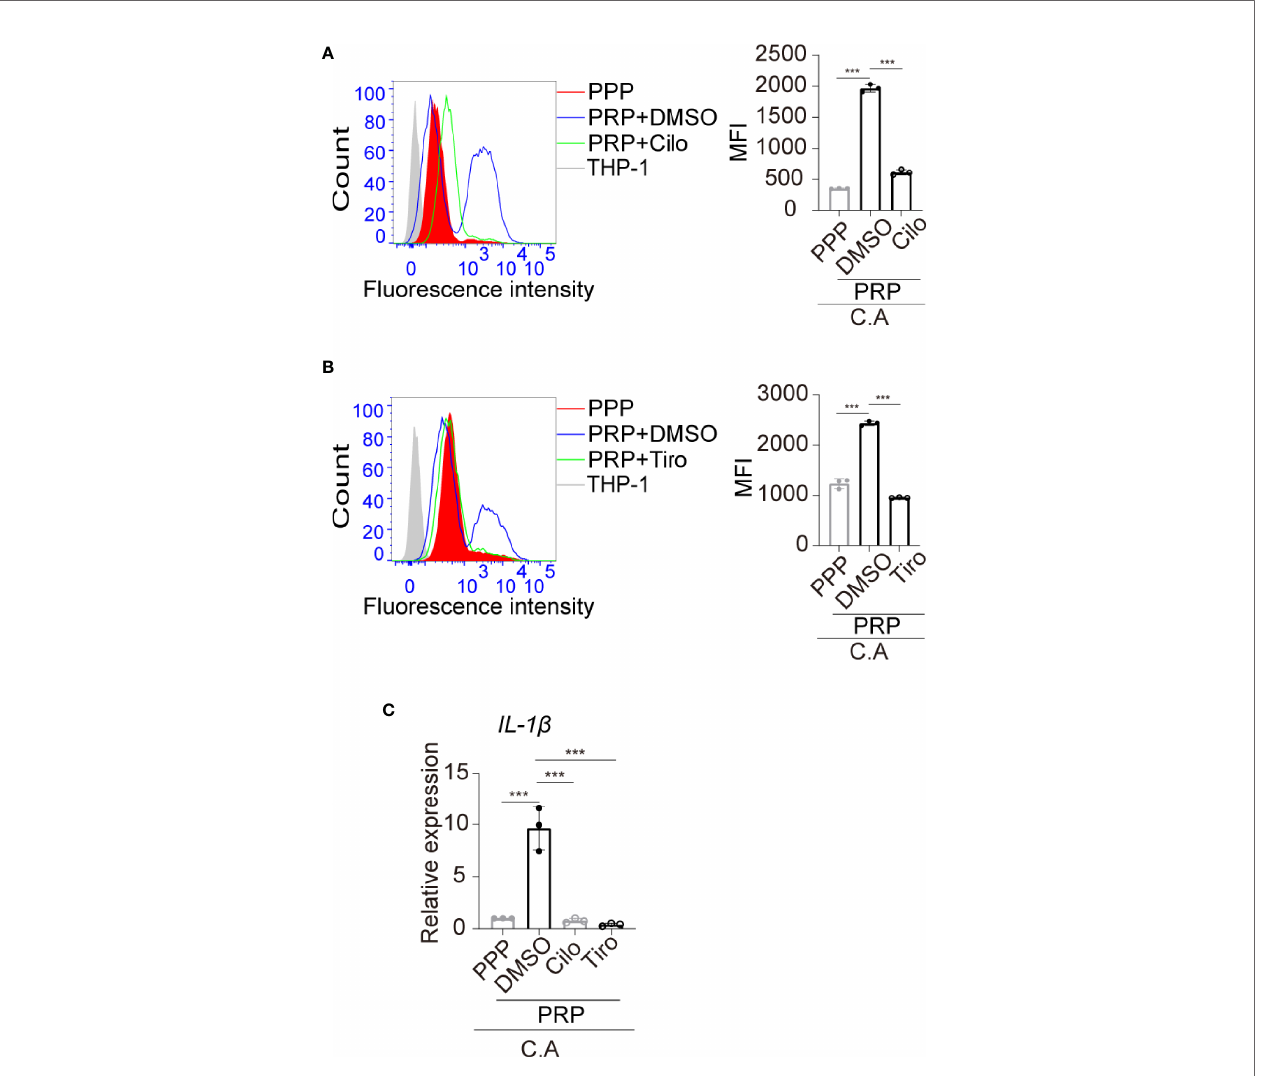
FIGURE 5 | The platelet-regulated immune response of monocytes is dependent on GP IIb/IIIa-mediated platelet activation. (A) PRP was pretreated with cilostazol (200 m M) or vehicle control at 37°C for 45 min and then incubated with THP-1 monocytes in the presence of FUN 1-labeled C. albicans at 37°C for 2h. The phagocytosis of FUN 1-labeled C. albicans by THP-1 monocytes was analyzed by fl ow cytometry. Untreated THP-1 cells were used as a negative control. (B) PRP was pretreated with tiro fi ban (200 m g/mL) or vehicle control at 37°C for 45 min and then incubated with THP-1 monocytes in the presence of FUN 1-labeled C. albicans at 37°C for 2h. The phagocytosis of FUN 1-labeled C. albicans by THP-1 monocytes was analyzed by fl ow cytometry. (C) mRNA expression of IL-1 b was analyzed by qPCR. ***P < 0.001 compared with one-way ANOVA followed by Bonferroni ’ s post hoc test (A – C) . C.A, C. albicans ; Cilo, cilostazol; Tiro, tiro fi